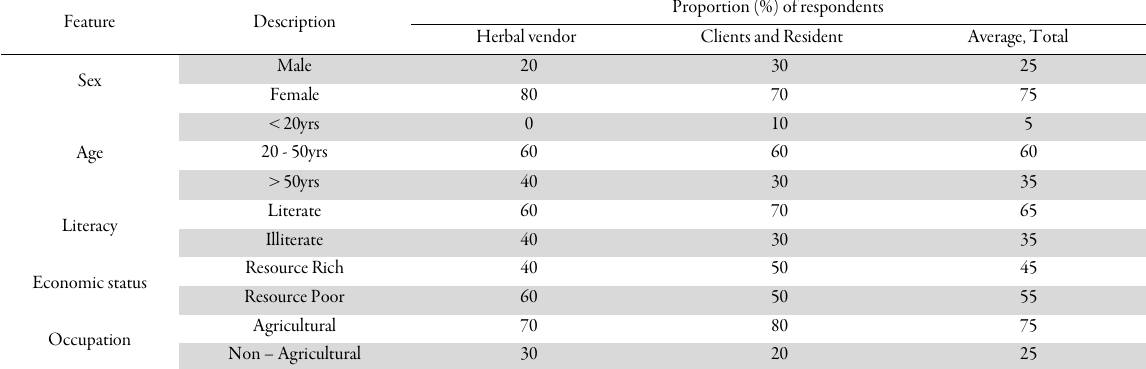
Table 1. Socio-economic classification of respondents sampled in Badagry Local Government area of Lagos State